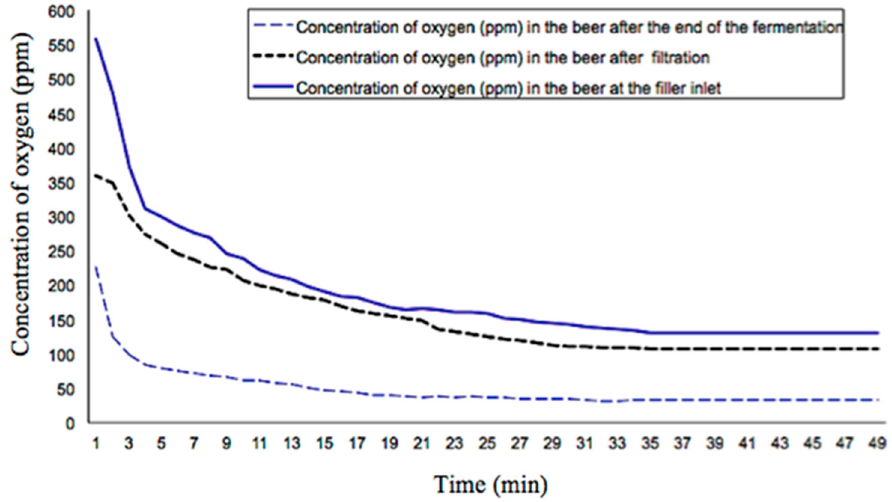
Figure 4. Monitoring of oxygen concentration during the process of beer production.